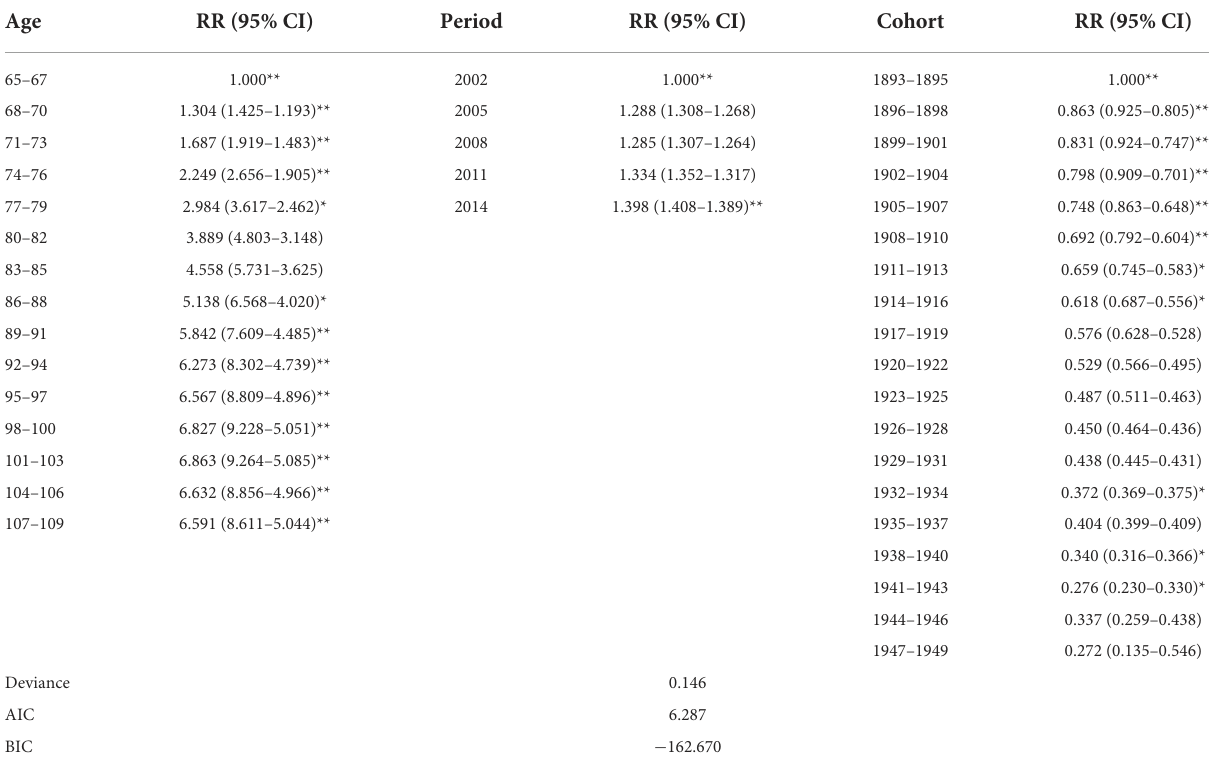
TABLE 3 Sensitivity analysis with frailty measured by frailty phenotype: Results of the APC model of prevalence of frailty among Chinese older adults during 2002–2014.